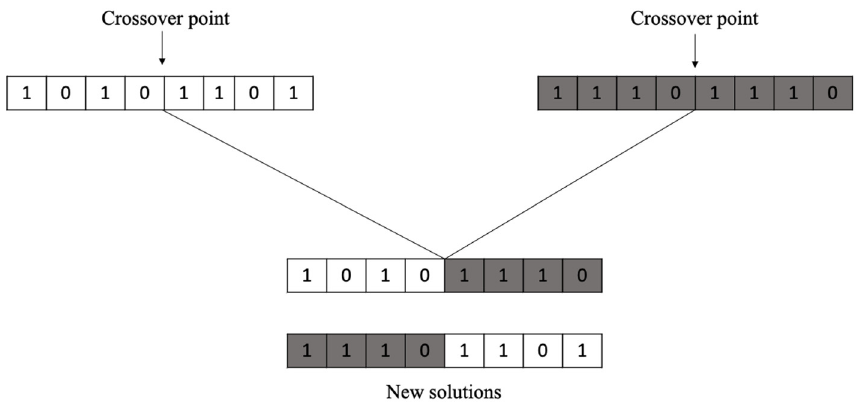
Figure 2. Example of one-point crossover operator at index cp= 3.